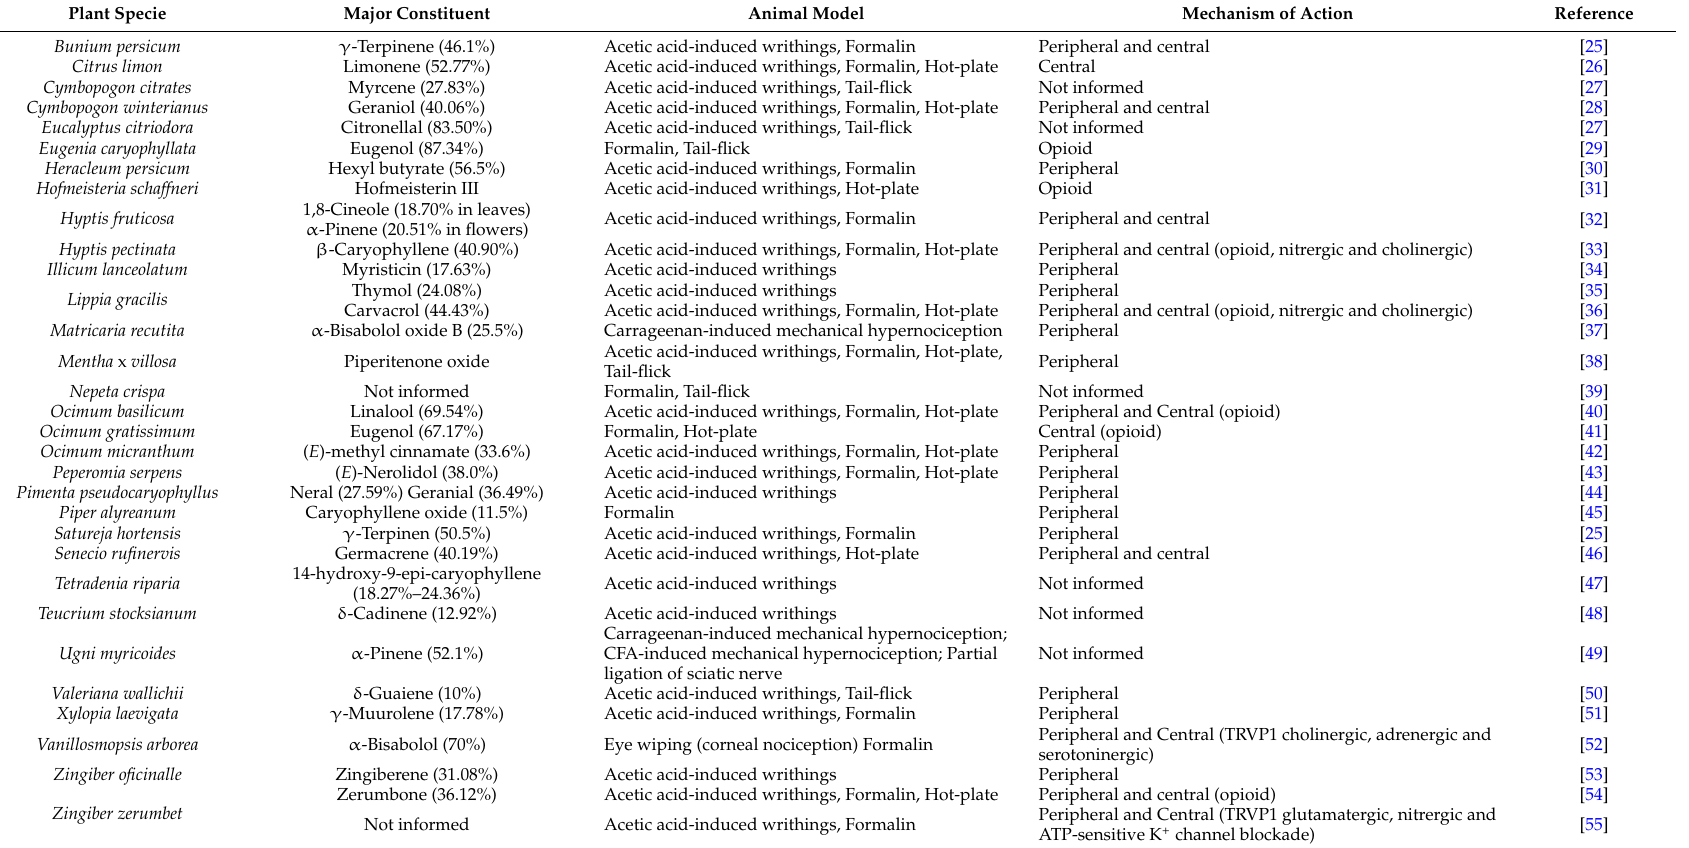
Table 1. Plants essential oils with analgesic-like